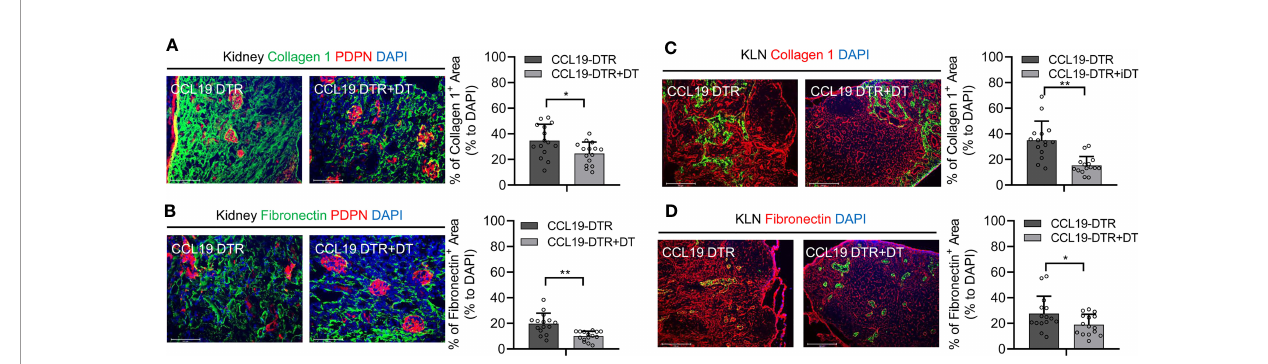
FIGURE 5 | Depletion of FRCs reduces fi brosis in KLNs and kidneys following UUO. (A, B) Fluorescence micrographs and semiquantitative analysis reveal signi fi cantly lower density of (A) collagen 1 fi bers (green) and (B) fi bronectin fi bers (green) normalized to DAPI-stained area (blue) in KLNs from CCL19-Cre x iDTR mice following FRC depletion (+DT) at Day 14 (n=5 random microscopic fi elds of sections from 3 mice). (C, D) Fluorescence micrographs and semiquantitative analysis reveal signi fi cantly lower density of (C) collagen 1 fi bers (green) and (D) fi bronectin fi bers (green) normalized to DAPI-stained area (blue) in kidneys from CCL19-Cre x iDTR mice following FRC depletion (+DT) at Day 14 (PDPN glomerular stain, red) (n=15 random microscopic fi elds of sections from 3 mice). Data represented by means ± SEM. *p < 0.05, **p <